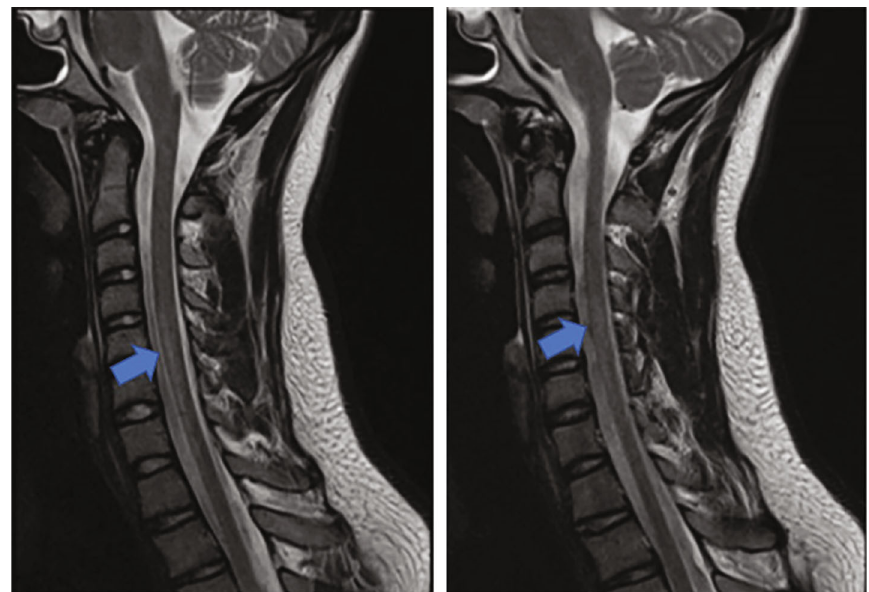
Figure 1: Spine MRI showing an extensive multisegmental T2-weighted hyperintense signal between the median plane of C4 and the transition from C7 to D1 (arrows) with symmetrical anterior medullary involvement and restricted di ff usion on DWI, but without spinal cord expansion or signs of spinal cord compression. There was a normal T2 vertebral artery fl ow void, with no apparent signs of acute vertebral artery dissection or intramural